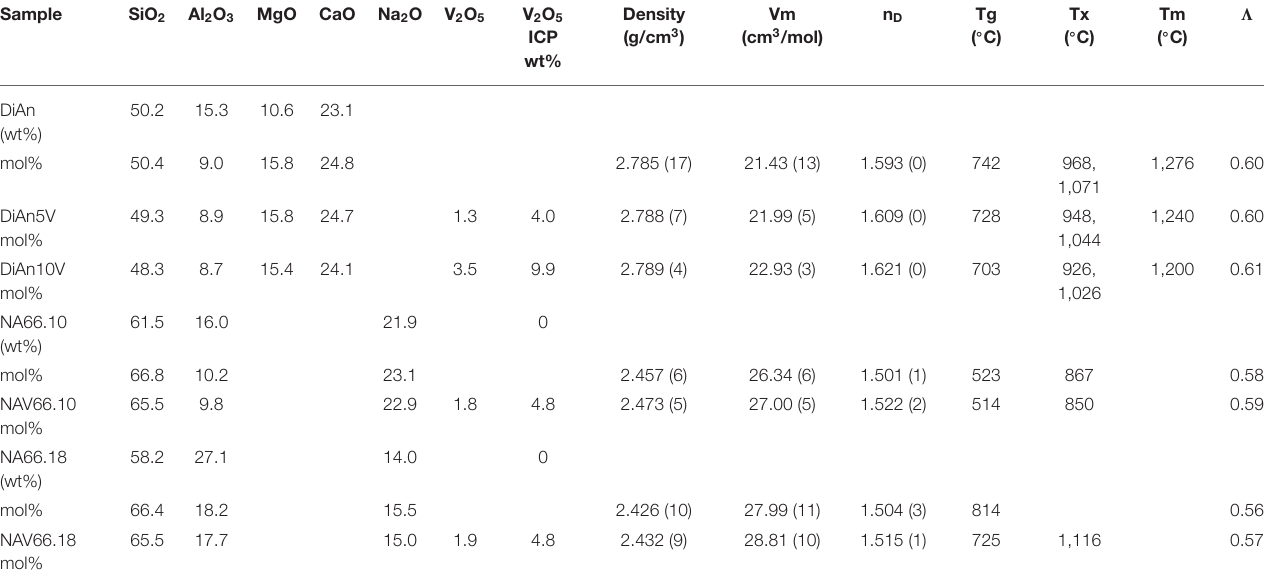
TABLE 1 | Percentage of mass determined by ICP analysis (wt.%) and the recalculated mol% of the investigated glasses.